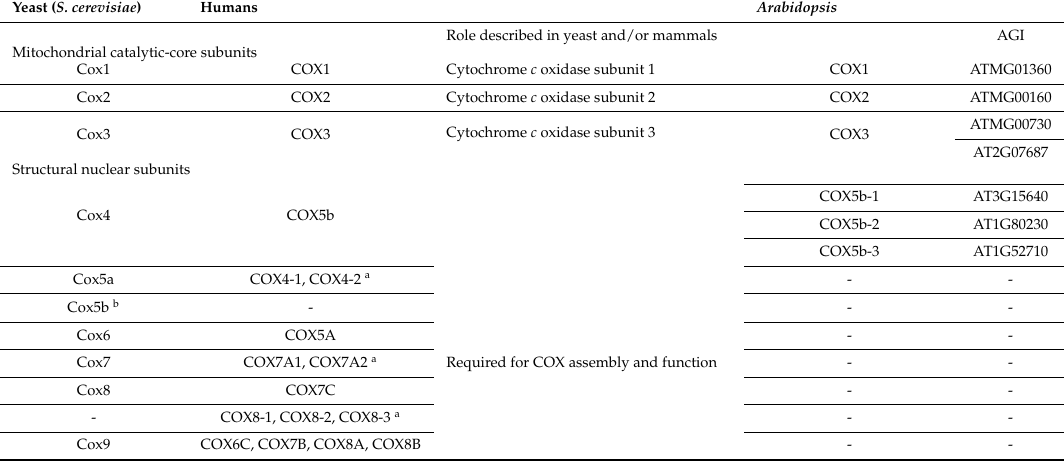
Table 1. COX subunits and assembly factors identified in yeast, humans and